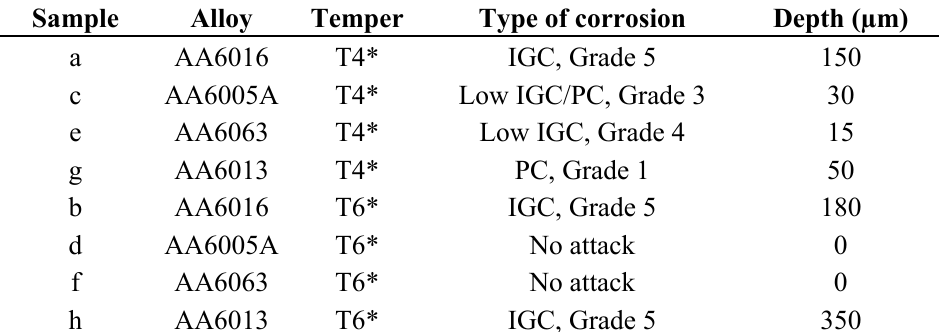
Table 7. Classification of corrosion behavior in temper T4* and temper T6*.